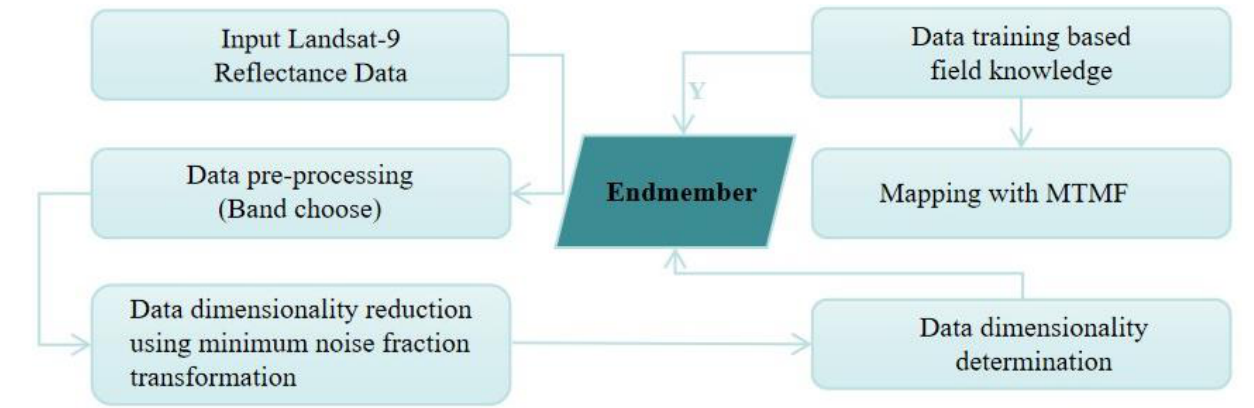
Figure 3. Flow chart of image processing and MTMF-based mapping steps.